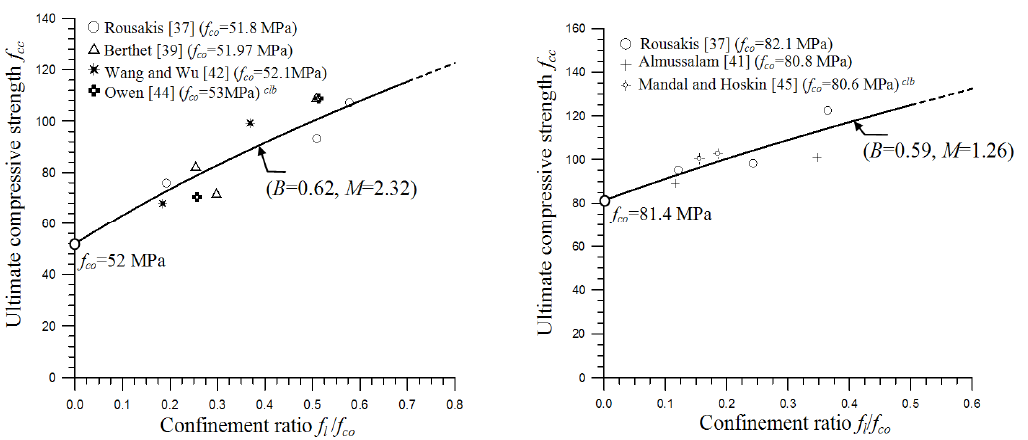
Figure 7. Verification of Johnston criterion for high-strength ( f confined